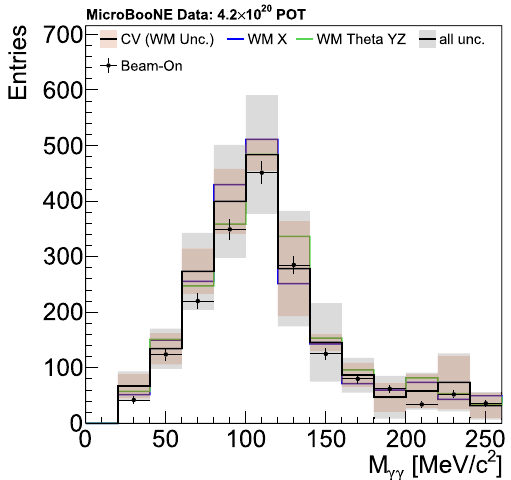
Fig. 12 Measured diphoton invariant mass distribution using BNB beam data (points) and central value (CV) simulation (black line), prior to additional shower energy corrections. The distribution for the simu- lation modified based on the detector response as a function of x (blue line) and θ YZ (green line) are also shown. The red band indicates the uncertaintyfromthewiremodificationalone(withallwiremodification uncertainties included). The gray band indicates the full uncertainty, including other detector uncertainties, as well as uncertainties on the neutrino flux and the interaction model. The bands represent the uncer- tainty on the number of events in that bin, calculated using Eq. (8), and are symmetric. The error bars on the data are statistical